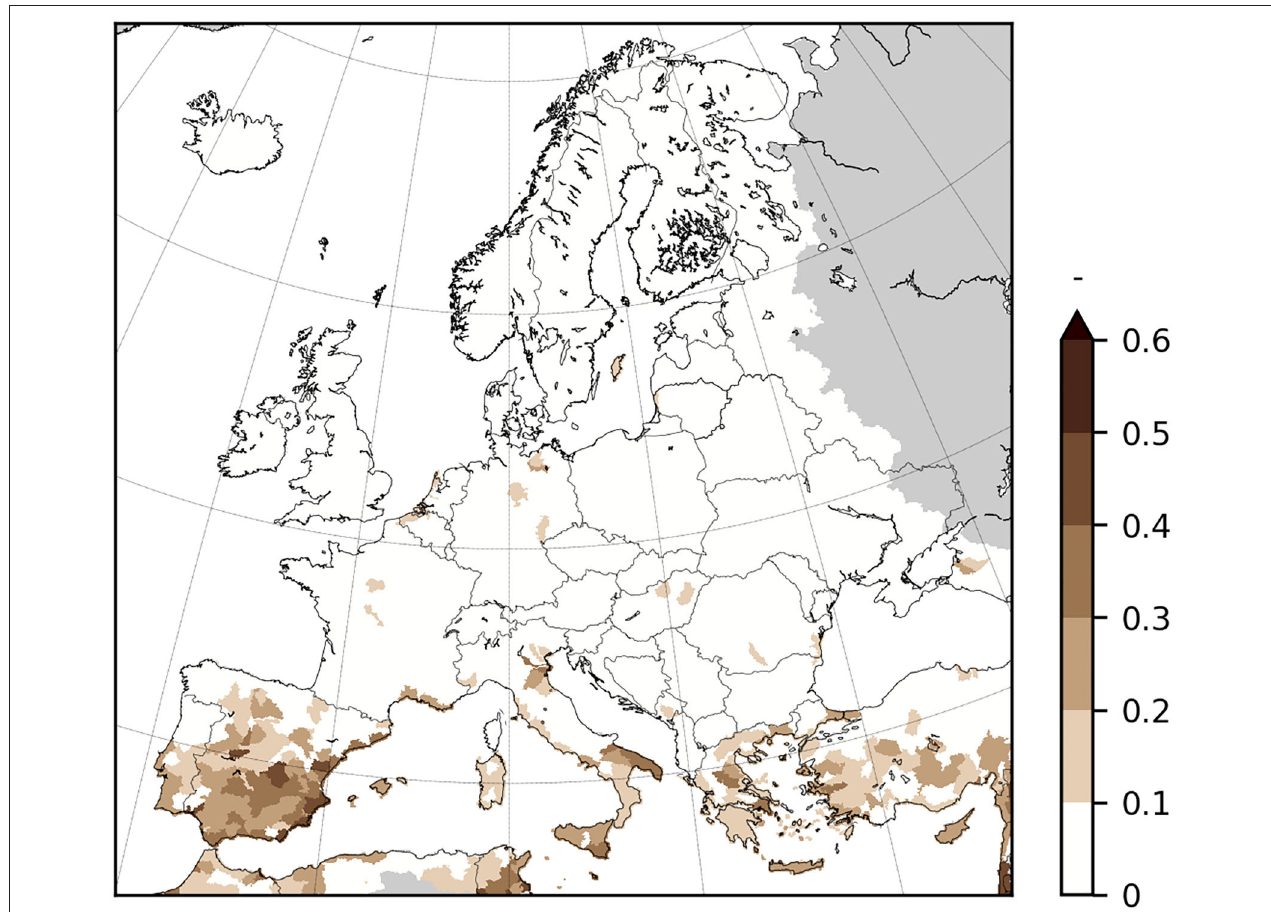
FIGURE 1 | The Water Exploitation Index (WEI + ) for present day climate (1990–2018) as simulated with the LISFLOOD